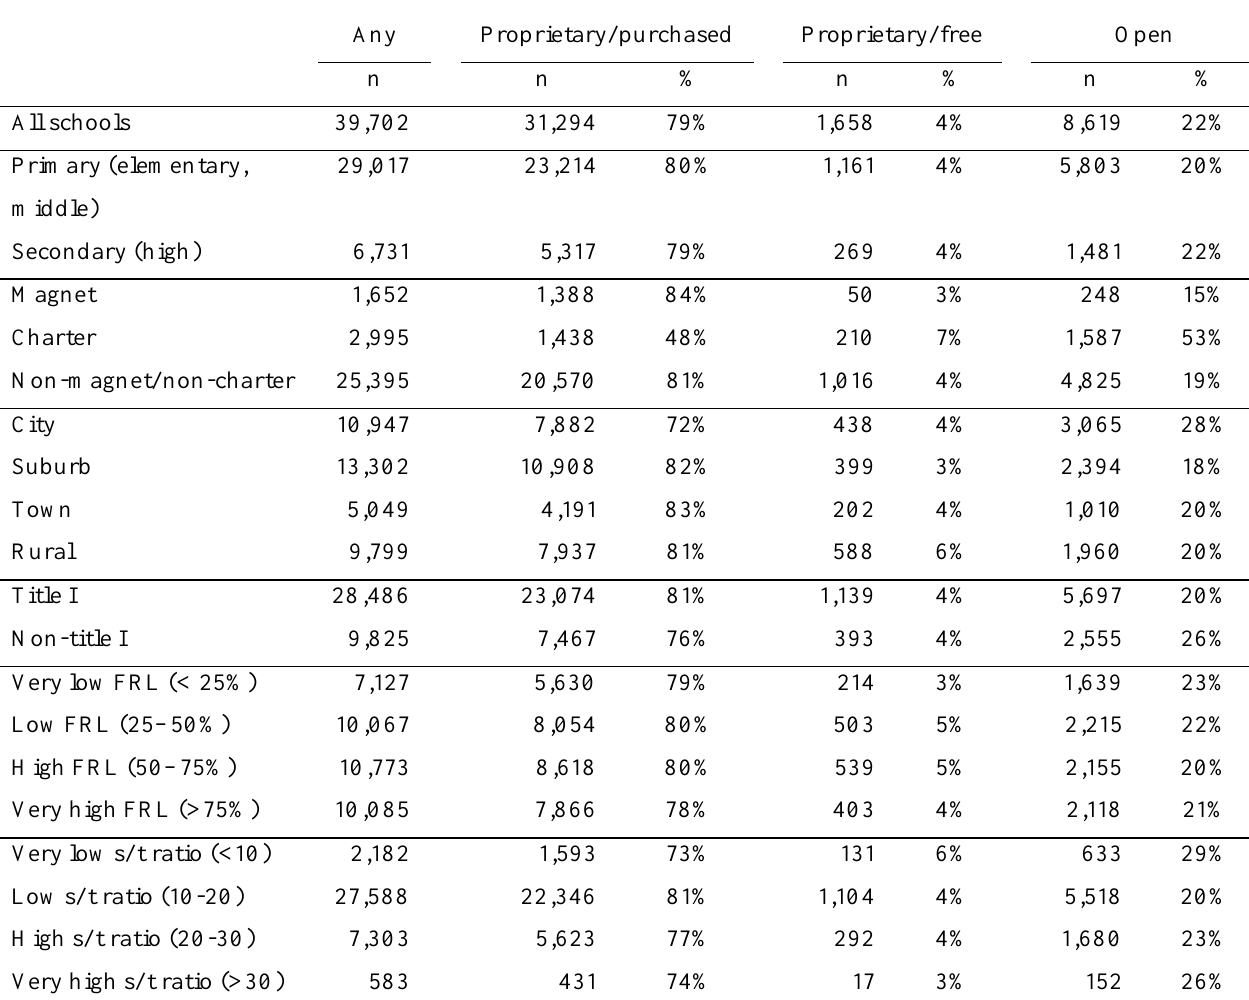
System Category